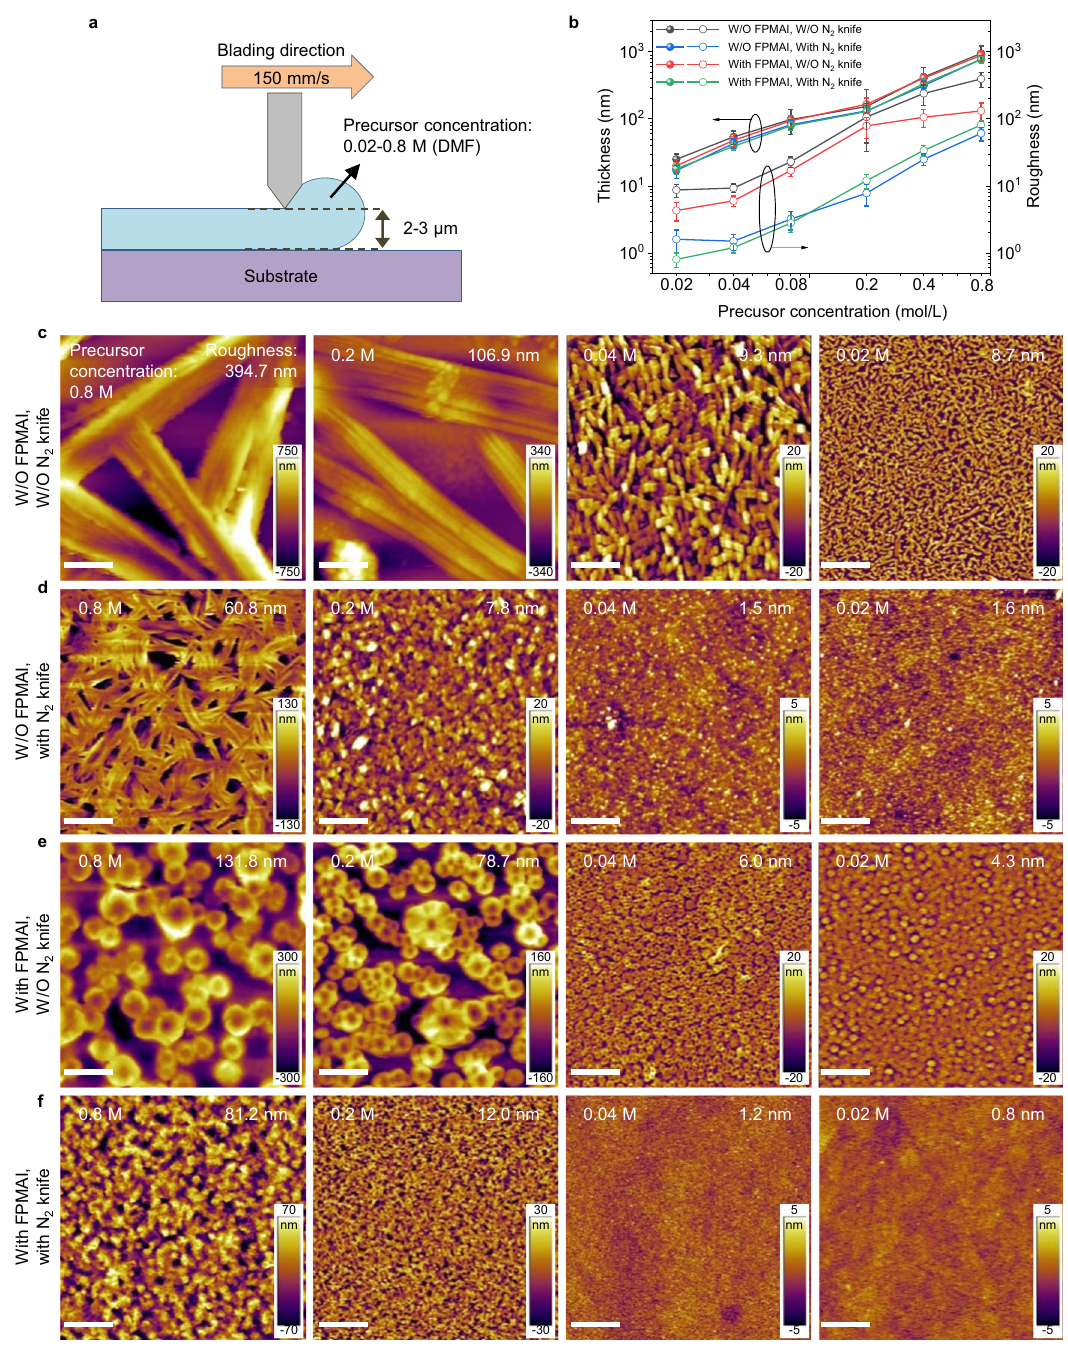
Fig. 1 Optimization of doctor-bladed perovskite fi lms. a A schematic of the doctor-blading process. b Thickness and roughness as a function of precursor concentration for different fabrication methods. The statistics of thickness and roughness of the fi lms are based on 15 scans (thickness pro fi ler) and 3 scans (AFM), respectively. Error bars represent standard deviation. c – f AFM surface morphologies of the blade-coated fi lms fabricated W/O FPMAI or N 2 knife ( c ), W/O FPMAI and with N 2 knife ( d ), with FPMAI and W/O N 2 knife ( e ), and with FPMAI and N 2 knife ( f ). The precursor concentrations and fi lm roughness are also marked in the AFM images. The scale bars are 5 µ Excitingly, the sol – gel stages change substantially for the dilute evaporating, more PbI 2 precipitates near the surface and the precursor (0.2 M) (Supplementary Movie 2). The schematics of existing PbI 2 precipitates grow slowly (Fig. 2b and Supplementary Fig. 8b). As a result, the nucleus density reaches 1.85 × 10 4 /mm 2 , the fi lm-forming process are shown in Fig. 2b. Stage 1. PbI 2 precipitation. With DMF evaporating, PbI 2 precipitates near the which is two orders magnitude higher than the case using dense surface. But PbI 2 precipitations do not grow as the wet fi lm/ink- precursor (Supplementary Fig. 8b). Stage 3. Aging. The PbI 2 - layer is not PbI 2 saturated. This stage starts at around 4.4 s. Stage DMF-MAI complexes continue growing slowly and start to 2. More PbI 2 precipitation and gelation. With DMF continuing convert to perovskite phase. Stage 4. Phase transformation.